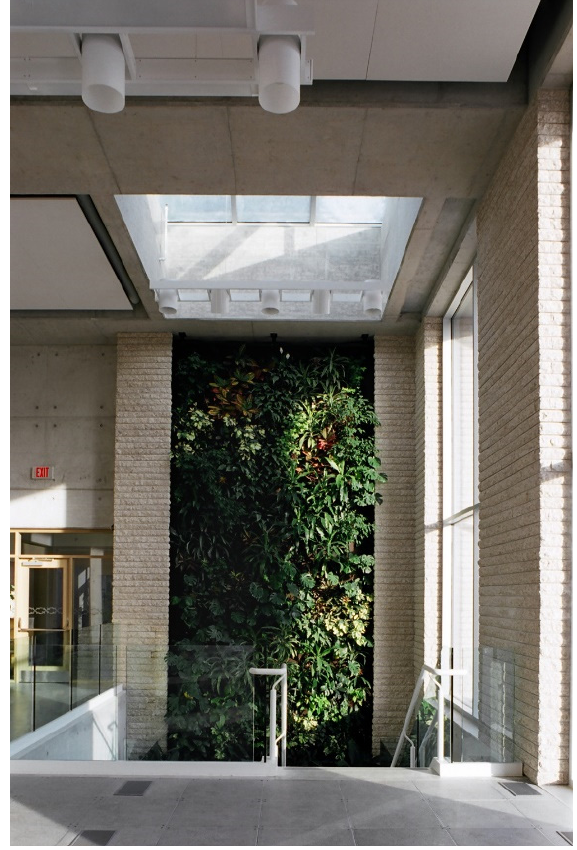
Figure 18. A close-up view of “living wall” from the narthex (Credit: Steven Evans). Alternatively, one can delay proceeding from the circle terrace point of orientation and can rather choose to journey deeper into the garden passed the remaining